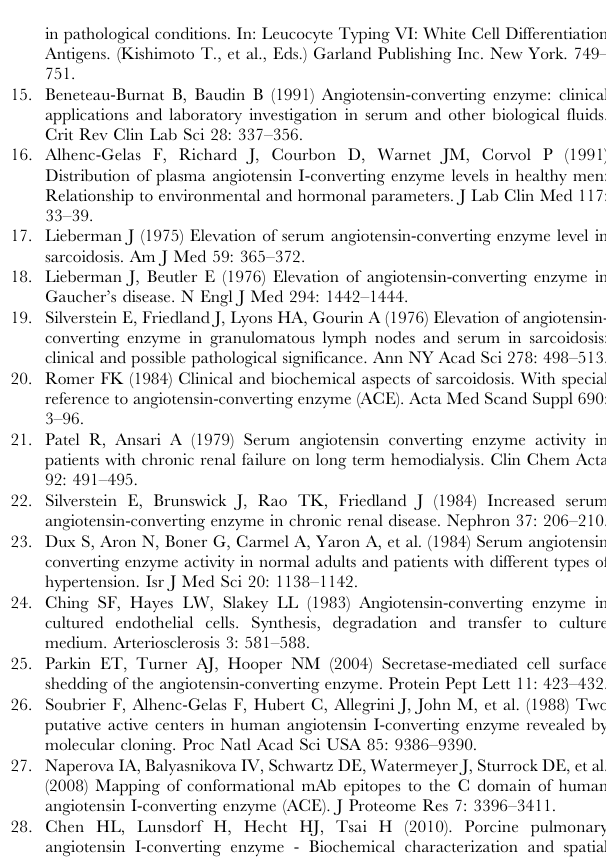
(each in duplicates). * - p , 0.05 in comparison with mean values for samples without treatment. Figure S6 Effect of ACE inhibitors on the blood ACE activity of healthy donors/unrelated patients with normal versus high 1G12/9B9 ratio. A – D Citrated plasma samples of unrelated patients and healthy donors with normal (patients # 2 healthy and # 19 unrelated), elevated (patients ## 11 and 18 healthy; ## 20, 32, 46, and 54 - unrelated) and high (patients # 13 healthy and # 21 unrelated) 1G12/9B9 ratio were incubated with ‘‘short’’ ACE inhibitor enalaprilat (100 nM, A and B ) and ‘‘long’’ ACE inhibitor teprotide (1 m M, C and D ) for 1 hour as in Fig. 7. Data are presented as a residual ACE activity determined with ‘‘short’’ substrate ZPHL (0.5 mM, A and C ) and ‘‘long’’ substrate angiotensin I (0.3 mM, B and D ). E . The ratio of the rates of the hydrolysis of angiotensin I and ZPHL (angiotensin I/ZPHL ratio) for corresponding samples. F . mAb 1G12/9B9 binding ratio for corresponding samples expressed as % from the mean value for controls. Grey bars – inhibition of ACE activity (A–D) or parameters measured in E–F in tested samples was not differed from that for healthy patients with low 1G12/9B9 ratio (controls). Red bars –measured parameters were statistically higher that in healthy patients with low (normal) 1G12/9B9 ratio *, p , 0.05 in comparison with mean value for healthy patients. Data are mean 6 SD from 3 independent experiments (each in duplicates). Figure S7 Effect of ACE inhibitor and bovine/human sera on mAbs binding to ACEs The effect of